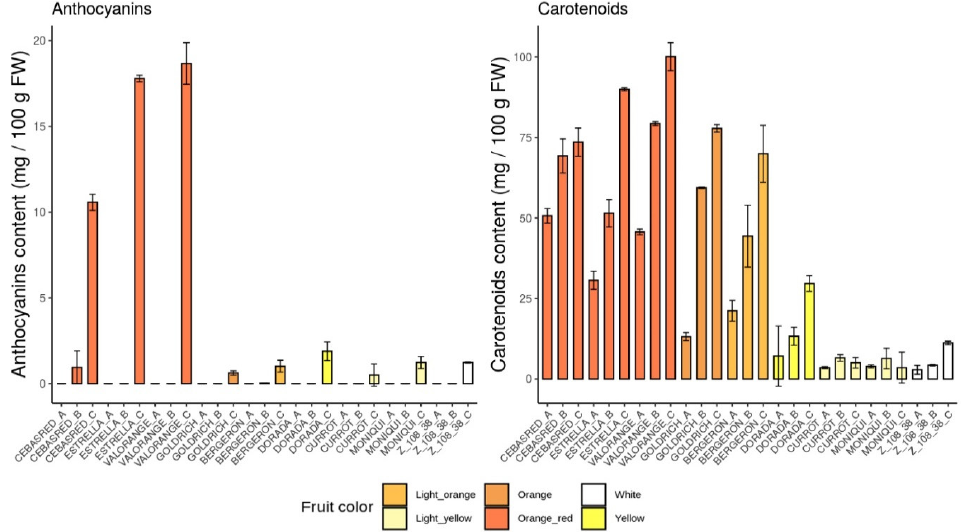
Figure 4. Anthocyanins and carotenoids content bar plots of the nine cultivars ‘Bergeron’, ‘Cebasred’, ‘Currot’, ‘Dorada’, ‘Estrella’, ‘Goldrich’, ‘Moniquí’, ‘Valorange’ and ‘Z 108-38 ′ at three different ripening stages based on their skin ground color and firmness: green fruit (Sample A), during color change (Sample B) and at physiological ripening (Sample C).